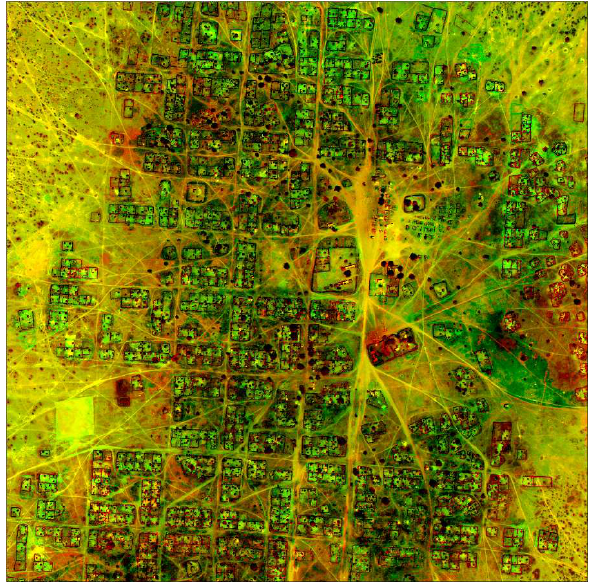
Figure 6. Falscolourcomposit for Donkey. Green = T1, Red =